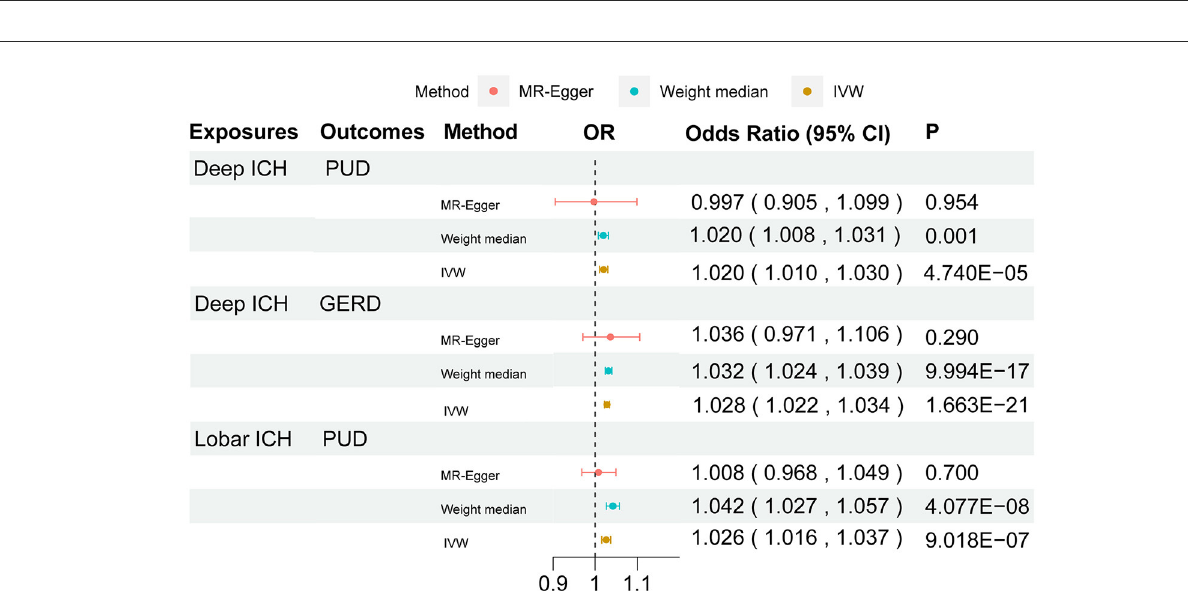
10 − 3 ). A bubble plot was used to show the statistical significance of the analysis (Figure 2). After that, the MR analyses with significant P- values were demonstrated in a forest plot (Figure